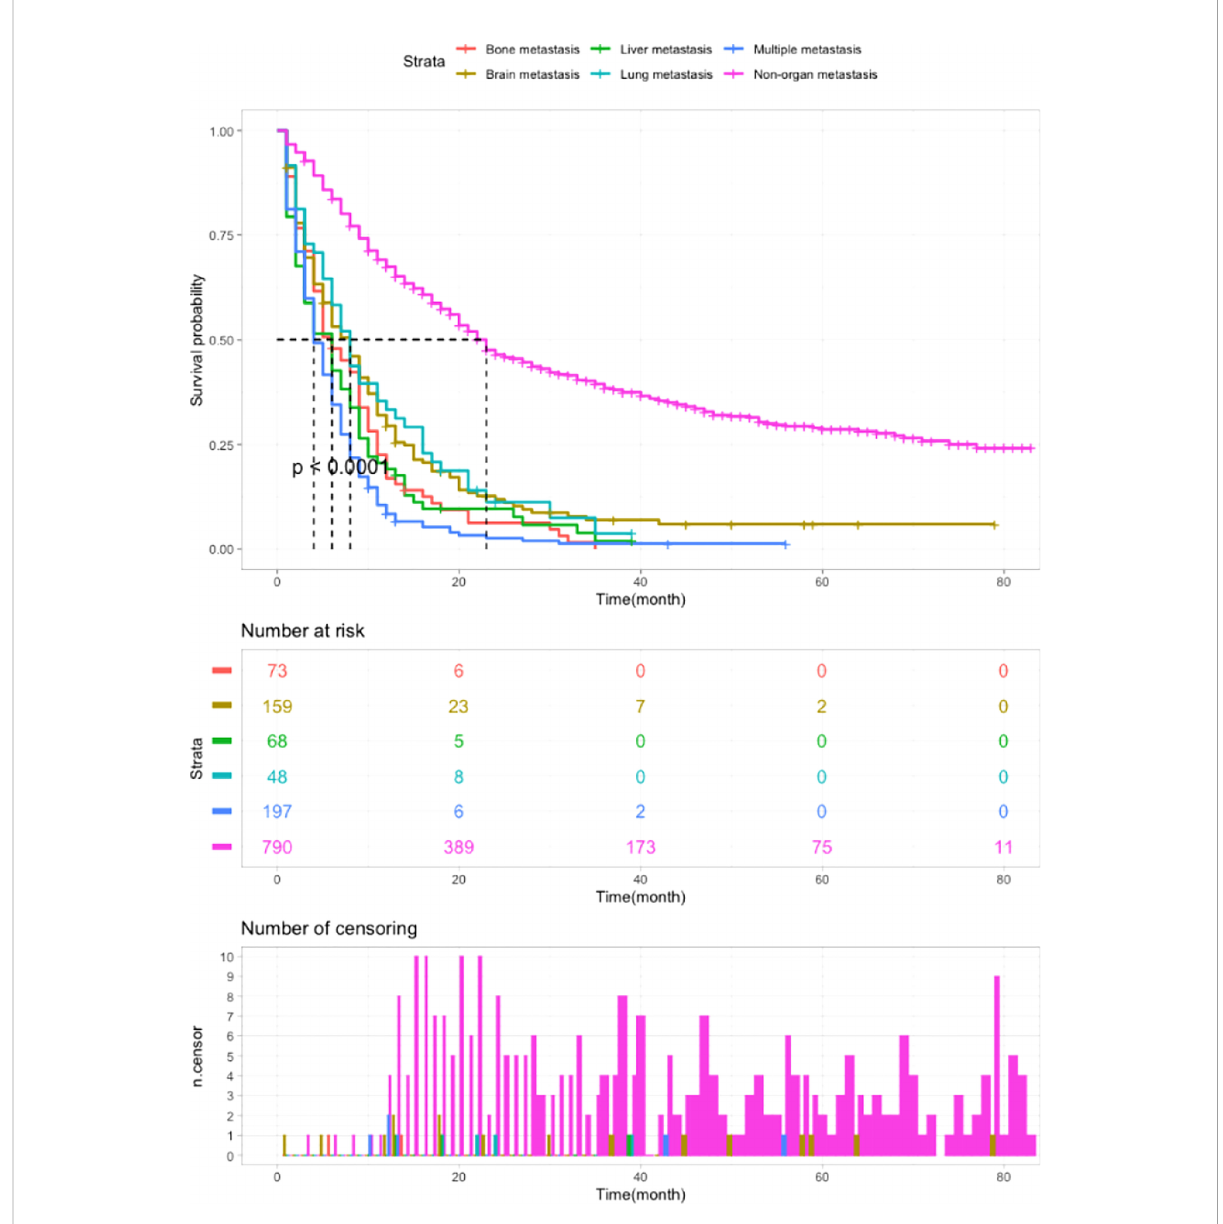
FIGURE 3 Kaplan-Meier analysis of the OS of LCNEC patients with different metastatic sites (P <